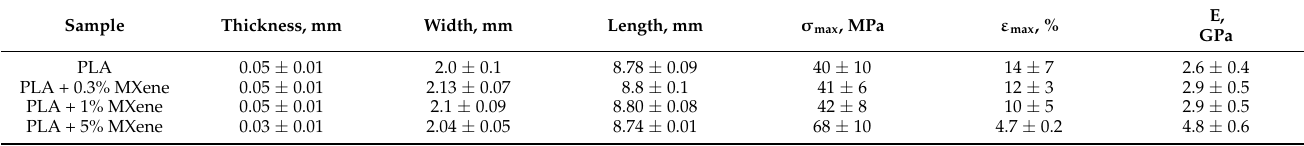
Table 3. Elongation at break ( ε max ), tensile strength ( σ max ) and Young’s modulus (E) values of the PLA and the composites with different loads (0.3, 1, 5 wt.%) of MXene. The average thickness, width and length of the 5 replicas for each test sample are also